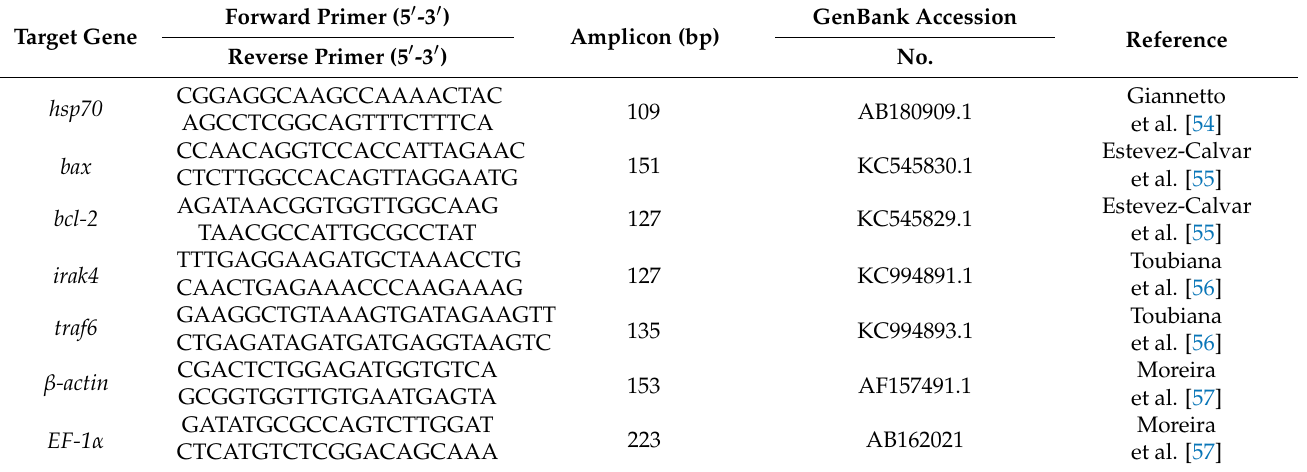
Table 1. List of primers used in this study and their amplicon sizes and Genbank accession number. Target